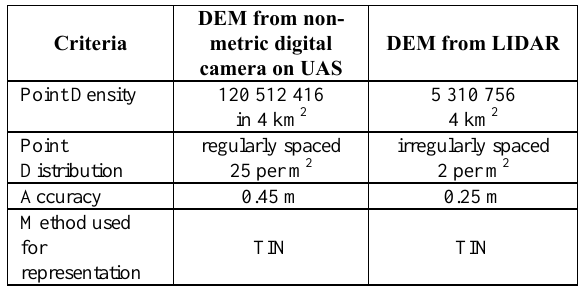
Table 2. Comparison criteria’s for DEM accuracy analysis